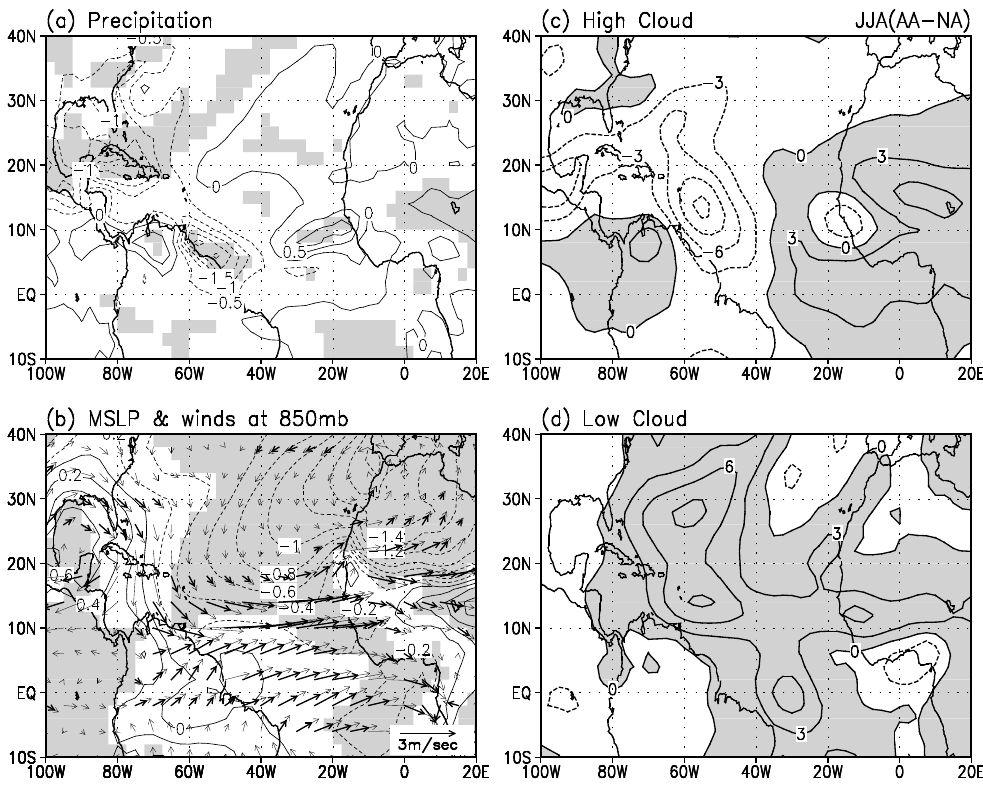
Fig. 3. JJA dust induced anomalies in (a) precipitation (mmday − 1 ) and (b) 850hPa wind (ms − 1 ) , and mean sea level pressure (hPa), (c) high cloud, and (d) low cloud amounts (%). Positive (negative) anomalies are indicated by solid (dotted) contours. Anomalies in precipitation and sea level pressure exceeding 95% statistical significance level are shaded. Wind vectors exceeding 95% significance are bolded. Positive anomalies of cloud amounts are shaded.